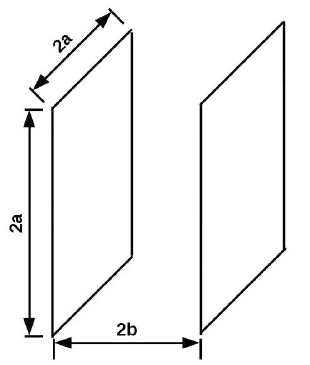
Figure 1. Square Helmholtz coil pair.